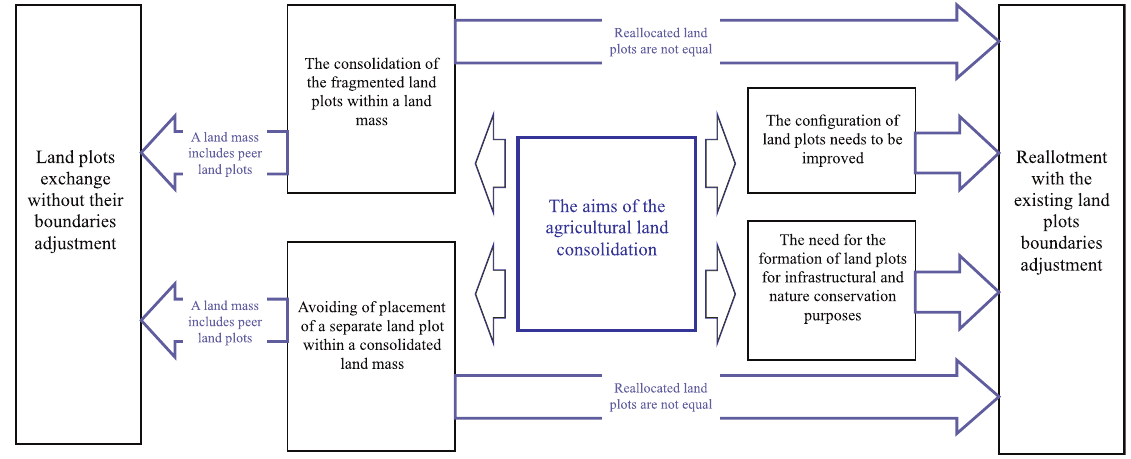
Figure 2. Land plots exchange and reallotment in the process of land consolidation Table 1. Land plots readjustment characteristics depending on the technical